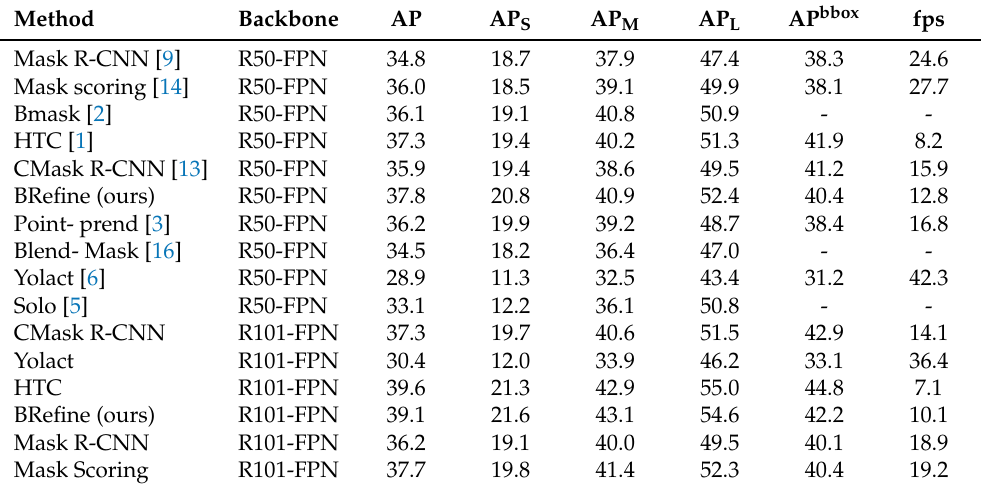
Table 2. Single-model comparison on COCO val2017. The above experiments were tested on 3 RTX 3090s using 1 training plans.